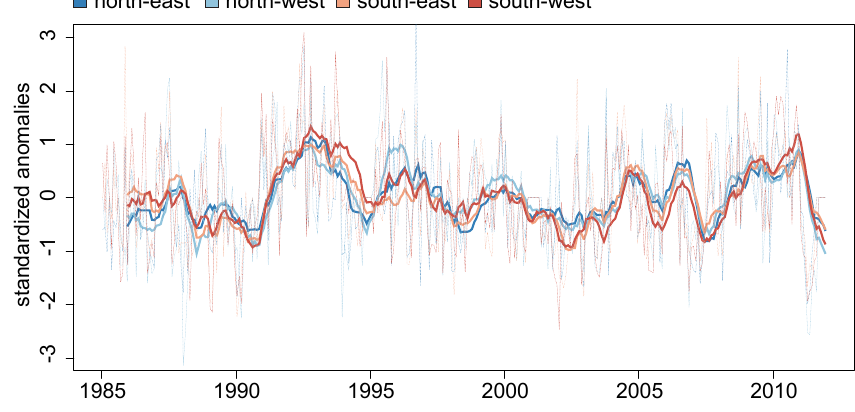
Fig. 11. Time series of Alpine region SCA monthly standardized anomalies derived from AVHRR data 1985–2011. The dotted line indicates the monthly values while the grey solid line depicts the 12-month standard moving average. The red line represents the respective linear trend.